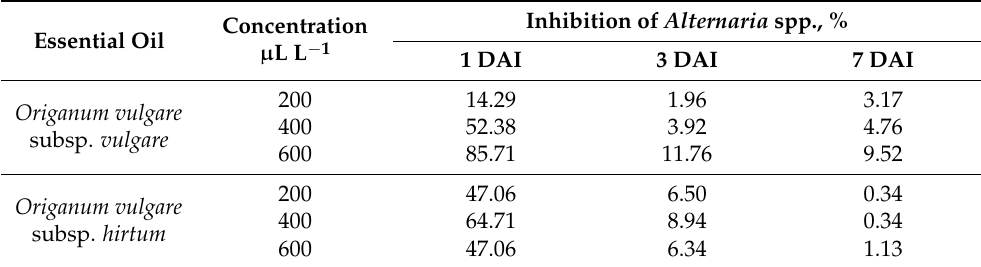
Origanum vulgare subsp. vulgare